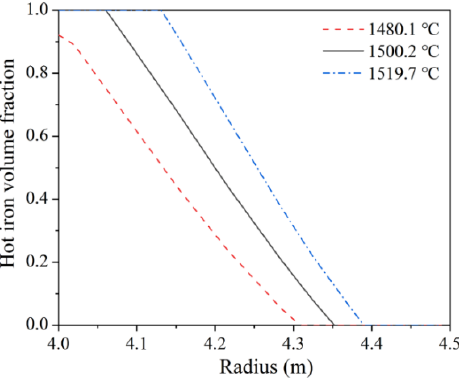
Figure 15. The volume fraction of hot iron on the evaluation line under different tapping tempera ‐ tures.